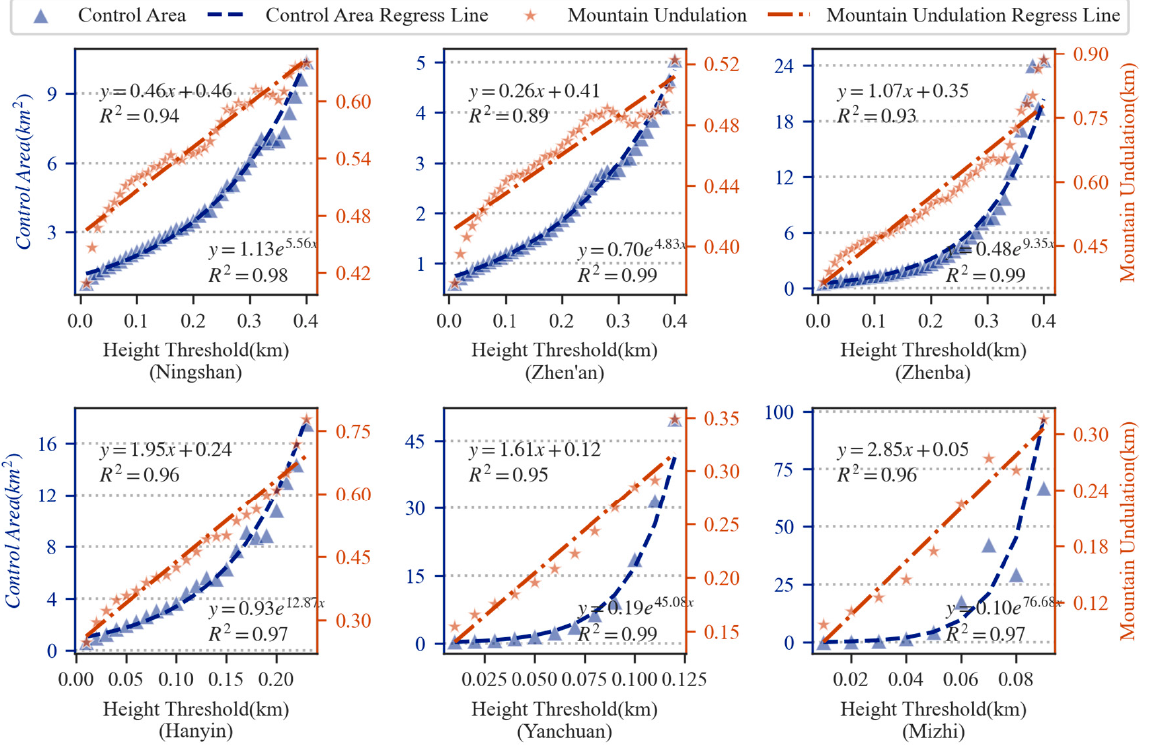
Figure 11. Response of mountain control area size and mountain undulation to HDPS changes in the six typical sample areas: the blue triangles represent the relationship between the HDPS and the mountain control area size; the orange stars represent the relationship between the HDPS and the mountain undulation; the blue and orange dashed lines represent the regression curves of the two.